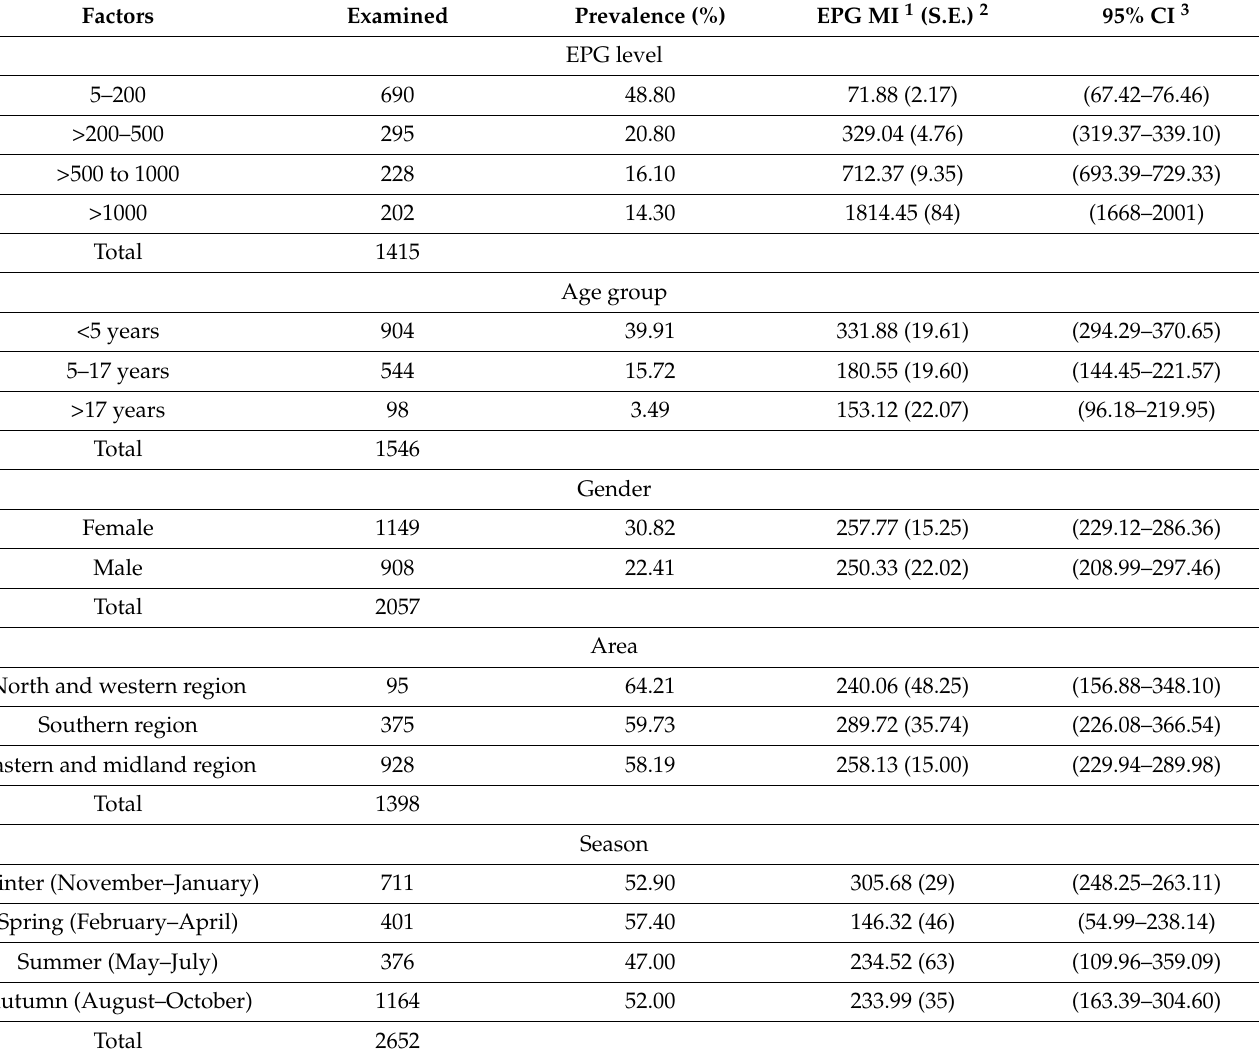
Table 2. The prevalence percentages and descriptive statistics for strongyle eggs per gram (EPG) found in the examined horses reported for different